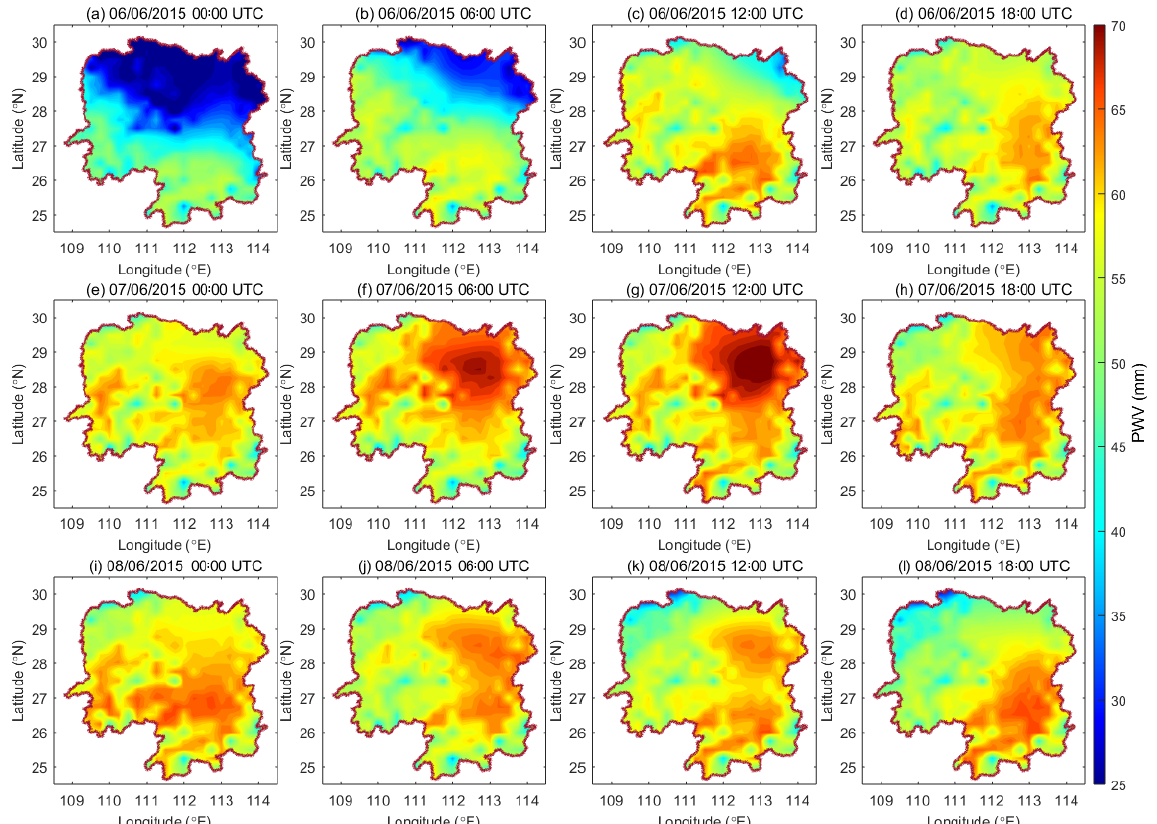
Figure 9. Evolution of GNSS-derived PWV maps for the Hunan Province every 6h from 00:00UTC, 6 June 2015, to 18:00UTC, 8 June